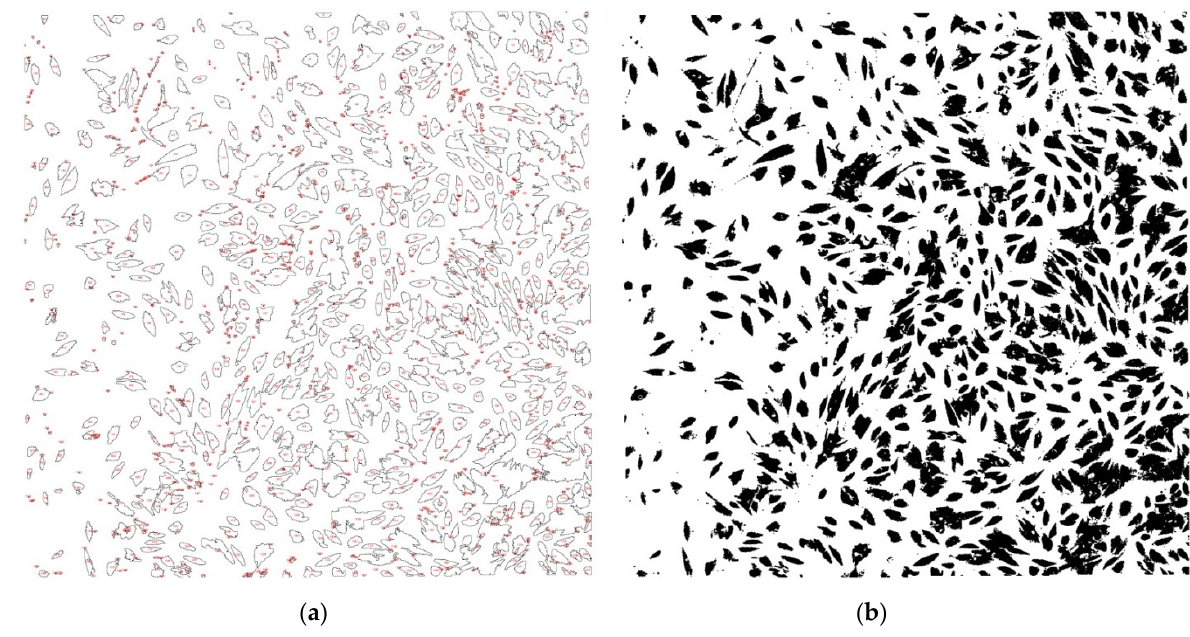
Figure 4. Quantification of cell proliferation: (laser “-”) ( a ) cell counting ( b ) binary.